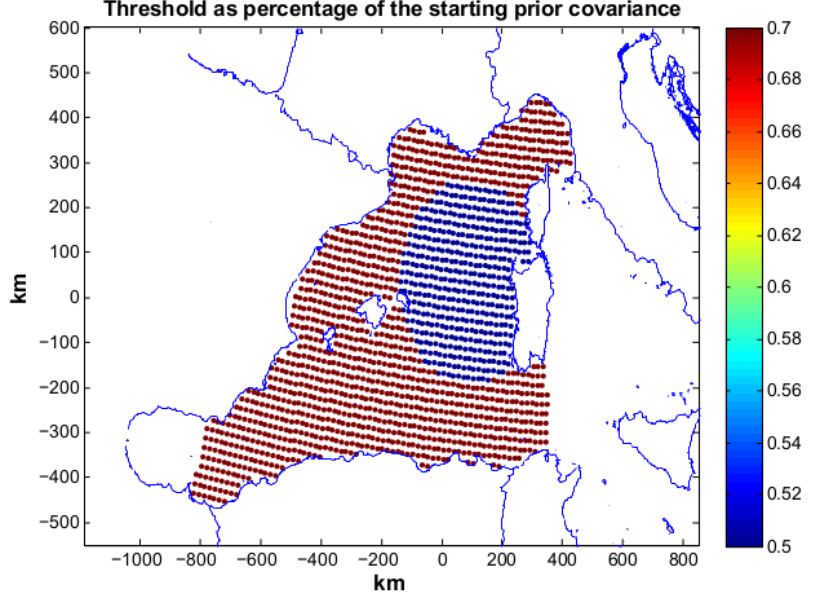
Figure 4. Threshold as percentage of the starting prior variances for scenario 2. The desired posterior is 70% of the prior in all of the area of study except that in a circular area with a radius of 230 km in front of the Sardinia coast where the desired posterior is requested to be 50% of the relative